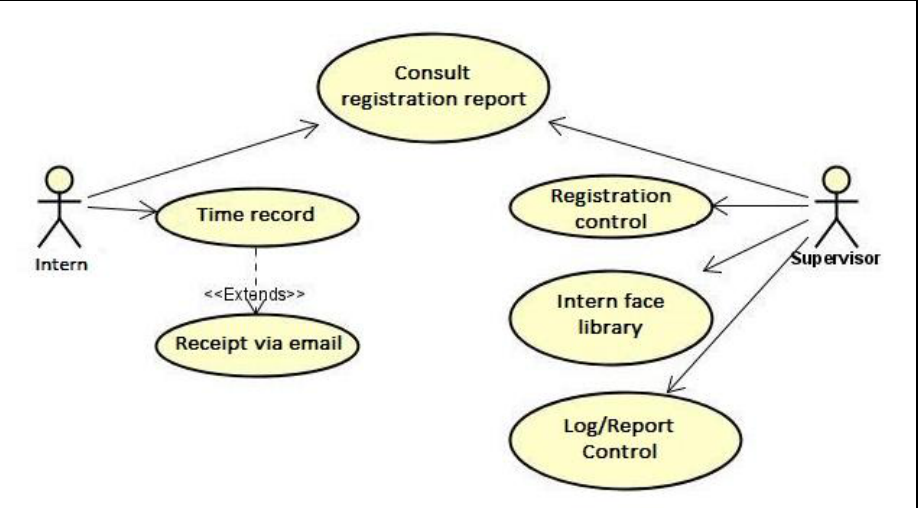
Figure 2: Diagram representing the use of the Time Clock.